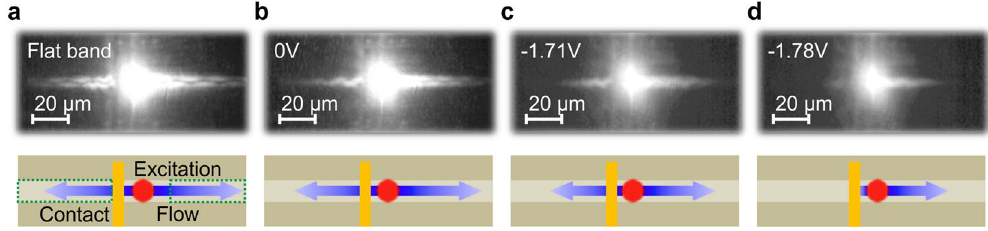
Figure 2. Polariton switching along the wire. Real space images of the studied microwire sample under optical excitation with the center of the pump spot approximately 15 µ m away from the center of the 10 µ m wide electrical contact (top) and schematic drawings of the experimental configuration (bottom). At the contact a voltage is applied and varied between flat band condition (U G = 1.8 V) and tilted bands (U G = − 1.78 V). Flat band conditions are reached when the external applied bias has equalized the built-in potential in the pin-doped structure and therefore leading to a nearly flat electronic band structure. Furthermore, tilted band specifies voltages in reverse bias leading to an increased potential and therefore to a strongly tilted electronic band structure. The real space images show the flow for different voltages ( a ) U G = 1.8 V, ( b ) U G = 0 V, ( c ) U G = − 1.71 V and ( d ) U G = − 1.78 V, respectively, at an excitation power of 20 mW. A clear flow to the right, away from the contact, and to the left, through the contact with respect to the excitation spot, is visible under flat band conditions, while with increasing negative voltage the flow through the contact stops abruptly. The green dashed boxes in the left most schematic drawing mark the integration ranges for the polariton flow through as well as away from the contact, discussed in Fig. 3.